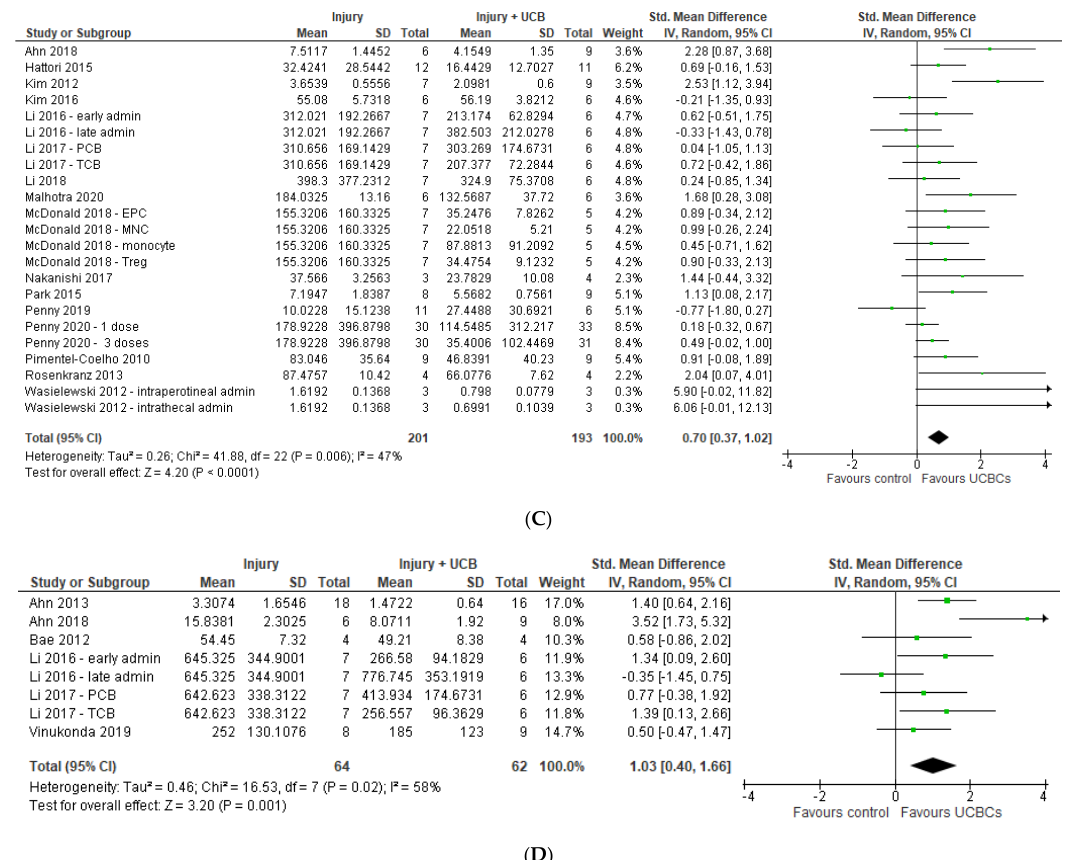
Figure 3. Forest plot demonstrating the effect of umbilical cord blood-derived cell therapy on ( A ) Astrogliosis—grey matter; (B) Astrogliosis—white matter; (C) Microglia activation—grey matter; (D) Microglia activation- white matter. Umbilical cord blood-derived cell therapy significantly decreased astrogliosis in both grey matter ( p = 0.01) and white matter ( p = 0.006), and decreased microglia activation in both grey matter ( p < 0.0001) and white matter ( p = 0.001).Abbreviations: admin, administration; ECFC, endothelial colony forming cells; EPC, endothelial progenitor cell; ICV, intracerebroventricular; IV, intravenous; MNC, mononuclear cell; PCB, preterm cord blood; TCB, term cord blood; Treg, T-regulatory cells; UCBC, umbilical cord blood cells.